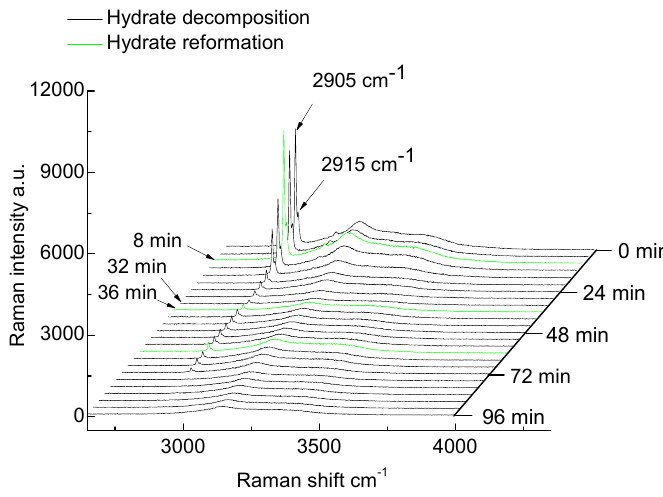
Figure 4. Methane hydrate decomposition at 253 K and atmospheric pressure.